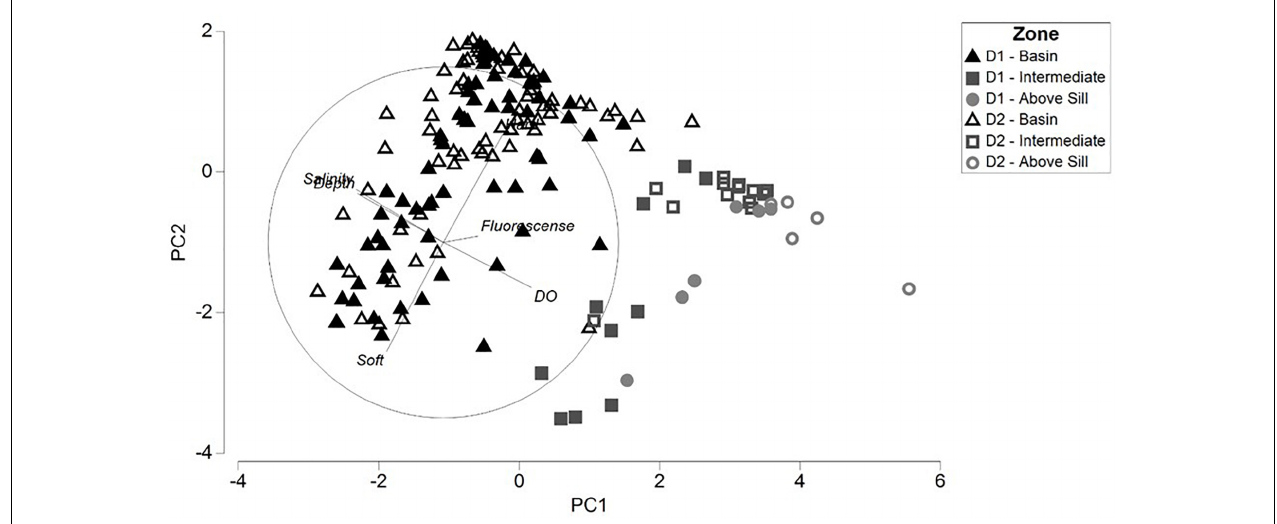
FIGURE 3 | Principal component plot of the abiotic variables for the depth zones within Dive 1 (closed) and Dive 2 (open), with the direction of the respective abiotic variables and their component score influence.